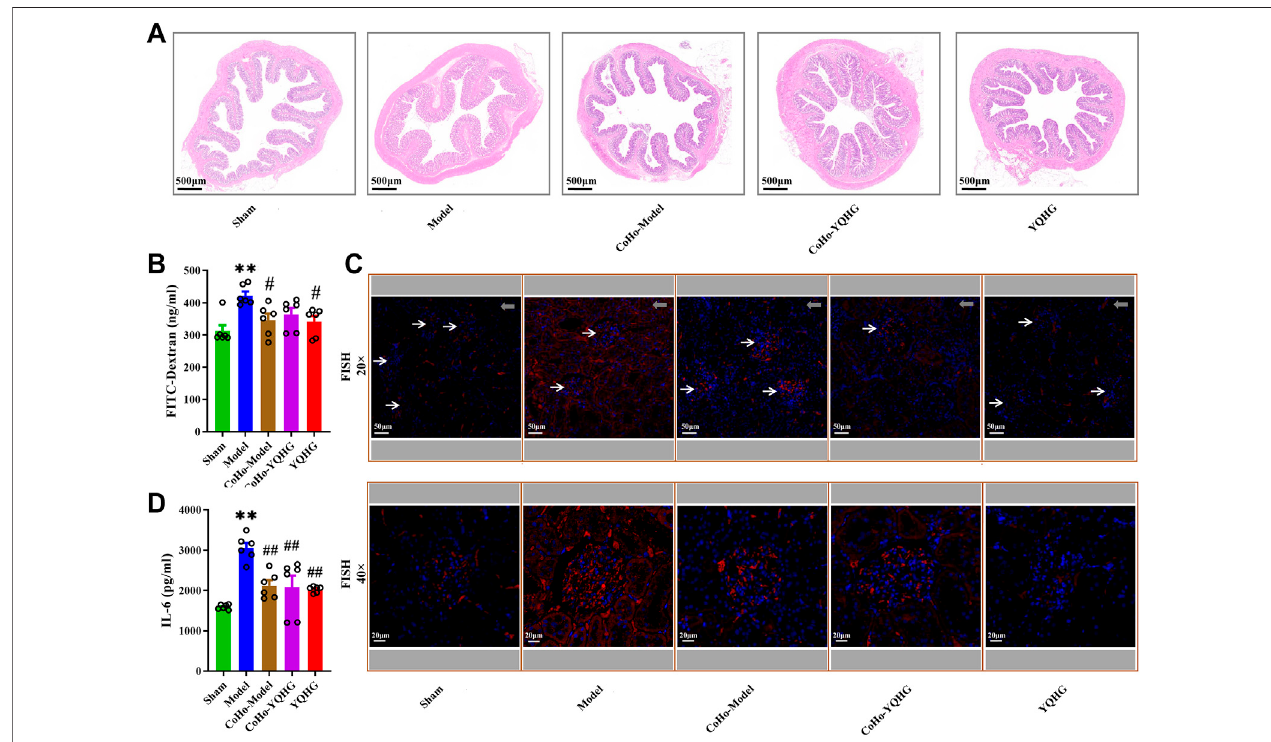
FIGURE9| ReceivinggutmicrobiotafromYQHG-treatedratsimprovesintestinalbarrierintegrity. (A) RepresentativeimagesofH&E(2.0×Magni fi cation,Scalebar 500 μ m)stainingofcolontissues. (B) TheconcentrationofFITC-dextraninserumwasdetermined. (C) RepresentativeimagesofFISHanalysis(20×Magni fi cation,Scale bar 50 μ m; 40 × Magni fi cation, Scale bar 20 μ m) in renal tissues. The red and blue fl uorescent signals represent the probe and the nucleus, respectively. White arrows represent glomerulus, and gray arrows represent tubulointerstitium (20 × Magni fi cation, Scale bar 50 μ m). (D) The expression of IL-6 in renal tissue was determined. All data are expressed as means ± SEM. For non-normally distributed data (FITC-Dextran, IL-6), Kruskal-Wallis test followed by non-parametric Wilcoxon rank-sum test was used. ** p < 0.01 vs. the sham group; # p < 0.05, ## p < 0.01 vs. the model group.